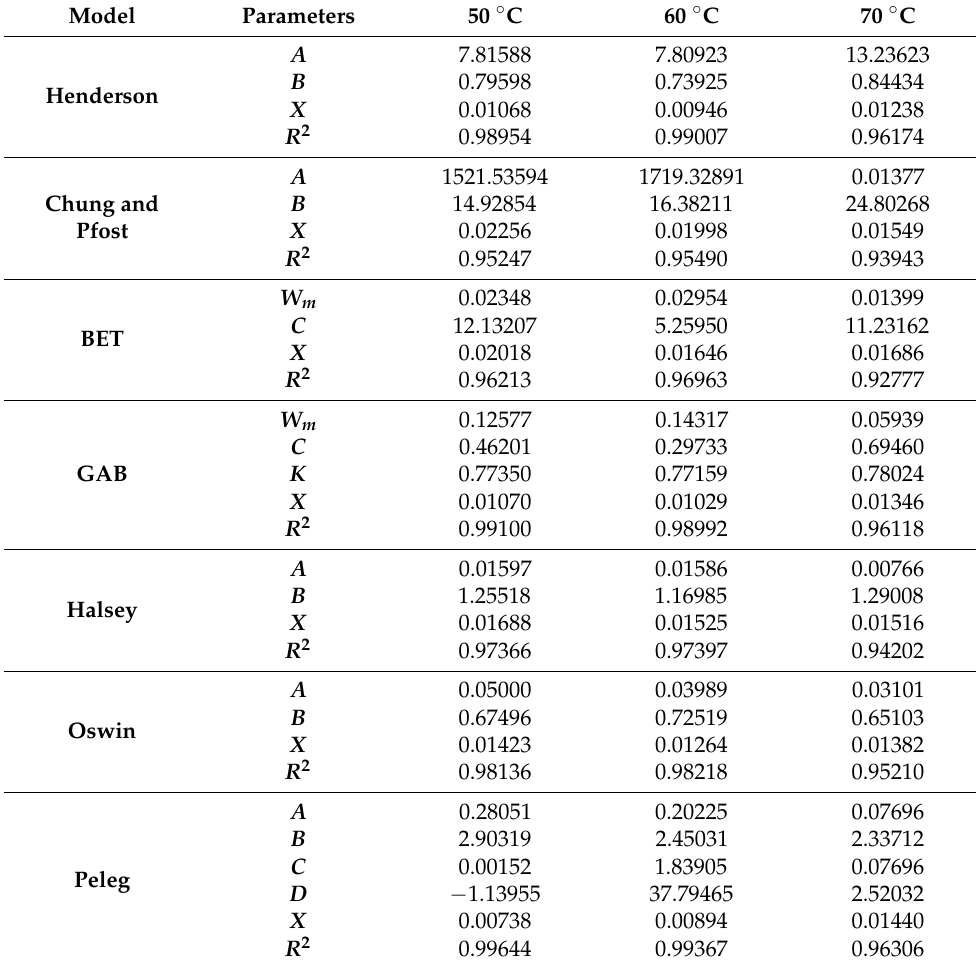
Table 6. Parameters of the models used for the prediction of experimental desorption data of corn